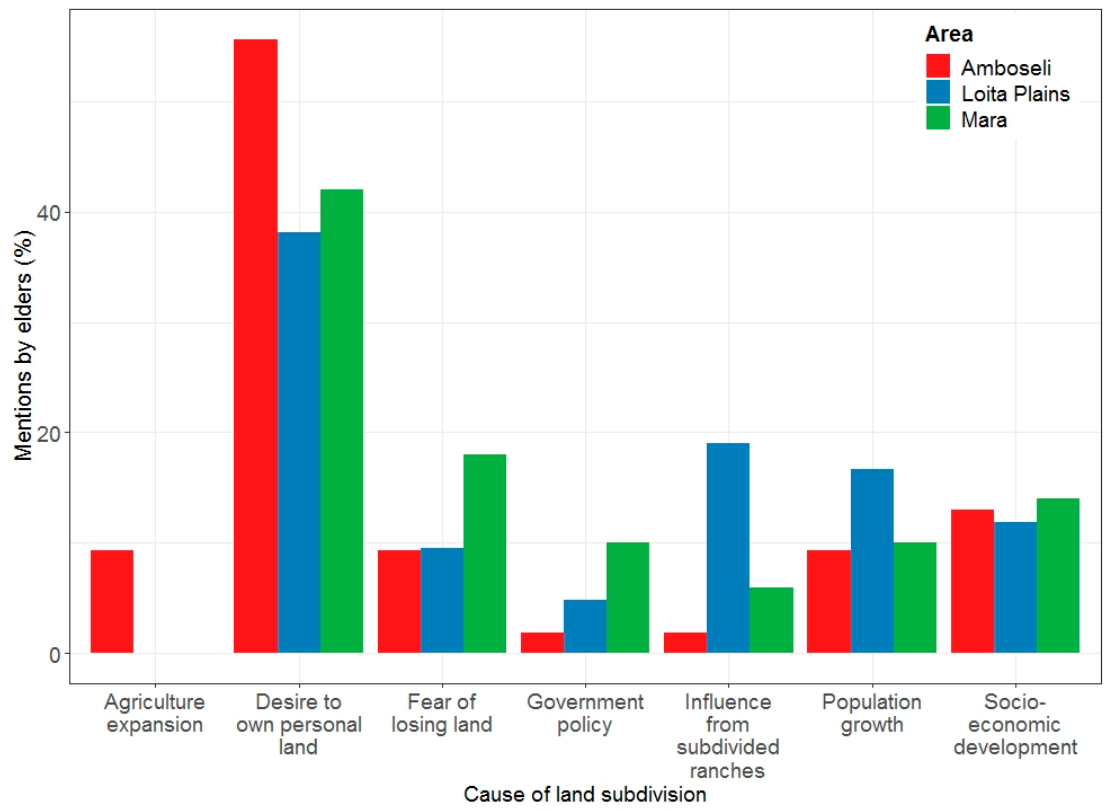
Figure 2. Causes of land subdivision, in percentage, as mentioned by community elders in Amboseli, the Loita Plains, and Mara in southern Kenyan savannas.